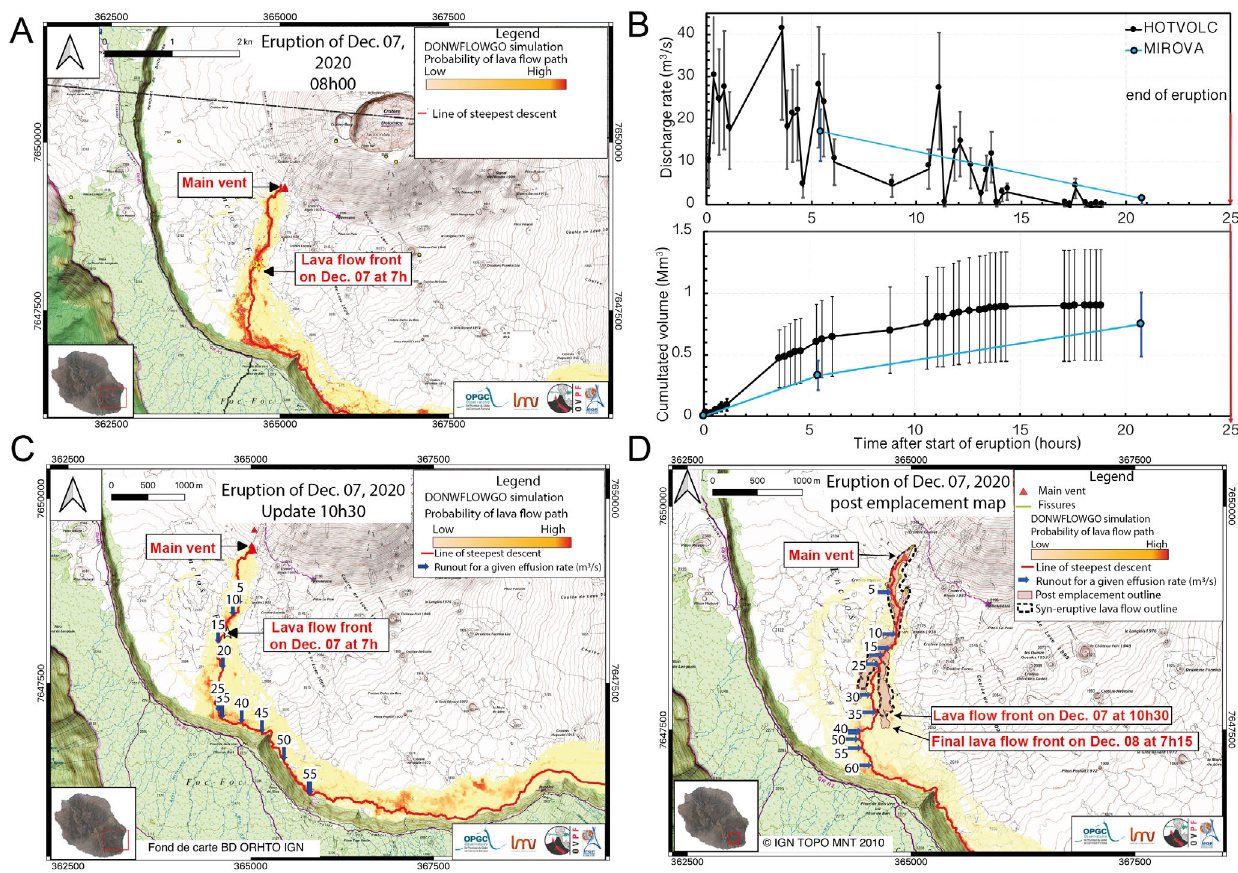
Figure 6: [A] First map produced on 7 December, 2020 at 08:00 RET. Note that the background is different than for previous maps and is the BD TOPO IGN® from IGN (see Section 5). This map was published in the OVPF monthly report of December 2020 (after the end of the eruption) [OVPF 2021]. [B] Lava discharge rate and cumulative volume since the start of the eruption obtained by HOTVOLC and MIROVA . [C] Update of the map produced on 7 December, 2020 at 10:30. [D] Final map showing the probability of lava flow invasion, runout distances as function of discharge rate and the final lava flow field outline obtained by photogrammetry. The lava flow outline drawn from the Sentinel-2 image acquired on 7 ecember at 10:30 is also shown. This map was produced after the end of the eruption.